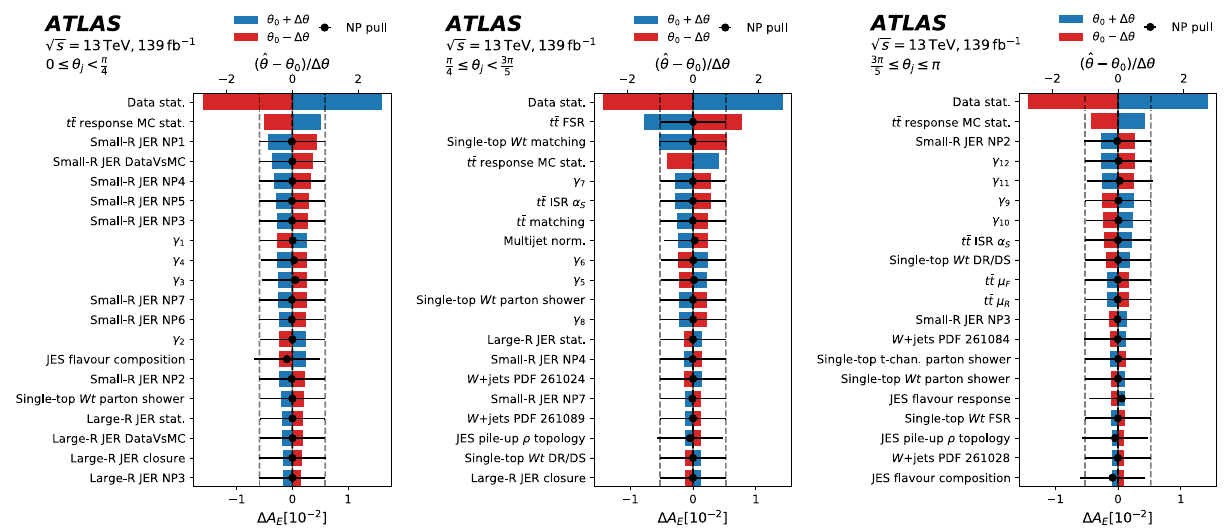
Fig. 6 Ranking of systematic uncertainties in the three θ j bins. The black dots and error bars (upper scale) denote the mean and standard deviation of the posterior distribution of the nuisance parameter, nor- malised to its pre-marginalisation standard deviation. The blue and red boxes (lower scale) show the impact on the energy asymmetry from